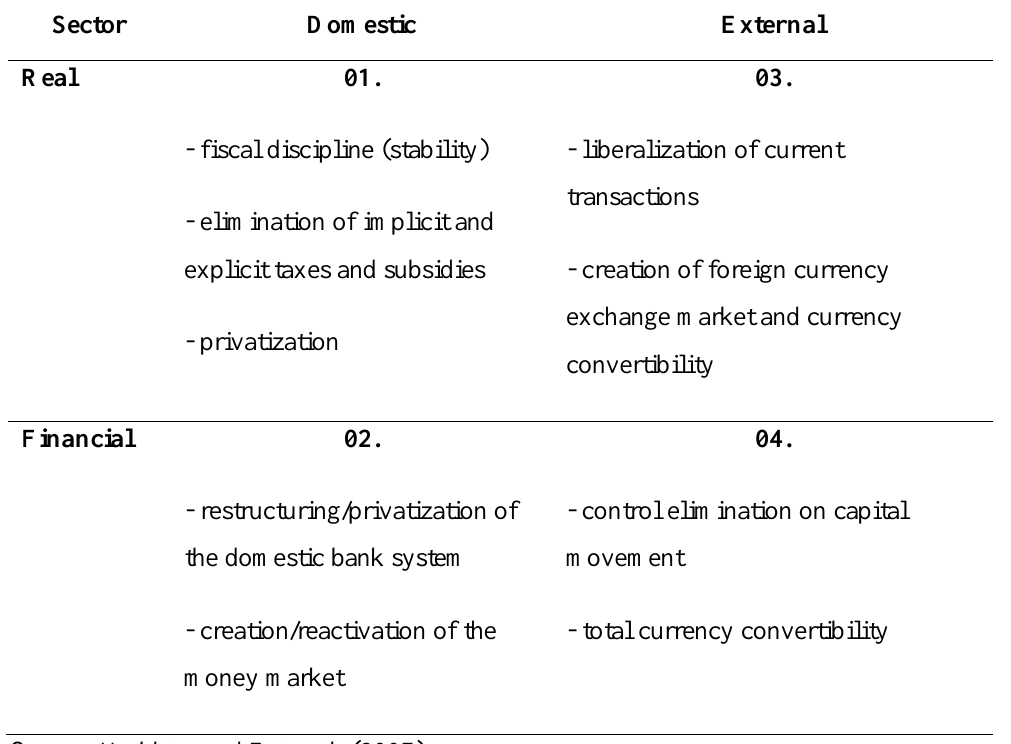
Table 1: Optimal Sequence of Liberalization